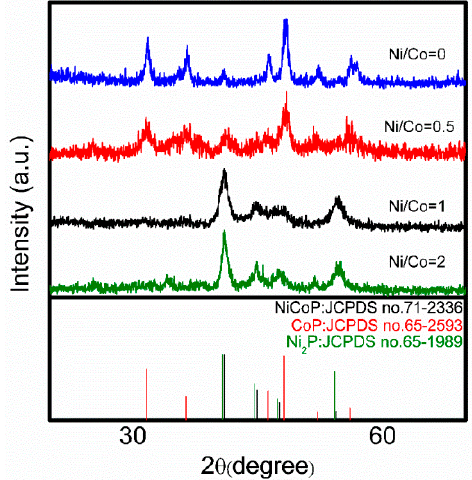
Figure 3. XRD patterns of the Ni x Co y P which prepared with different Ni/Co molar ratios.